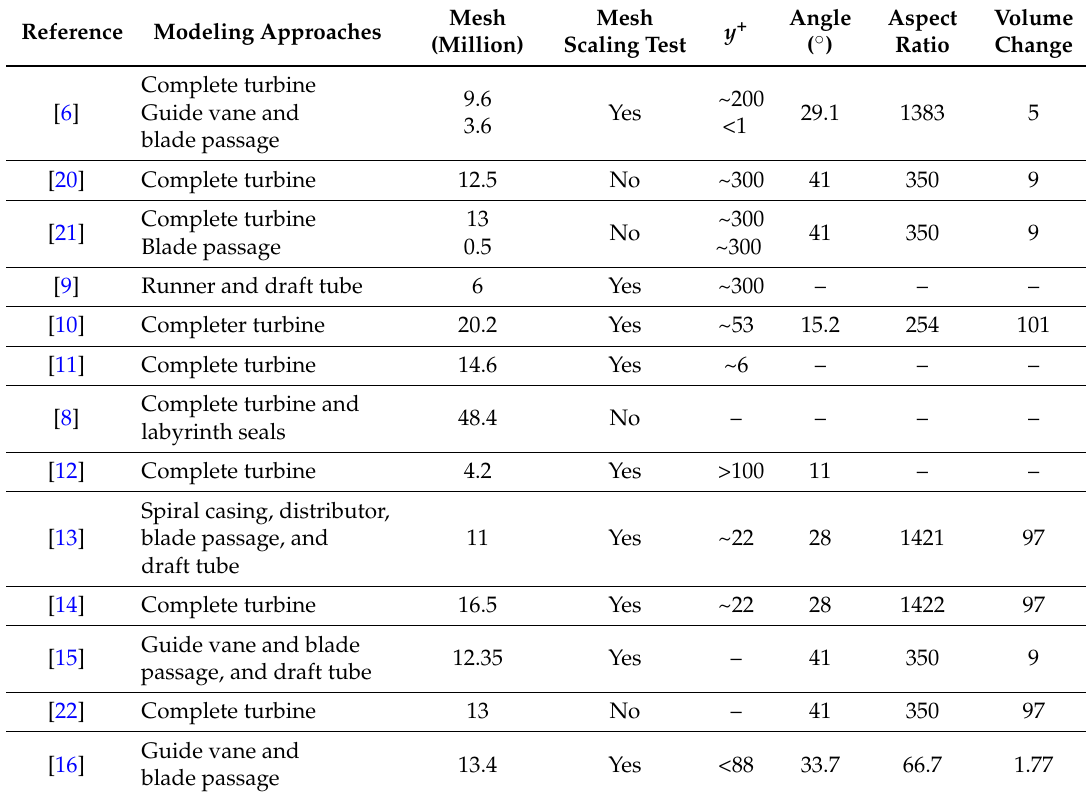
Table 3. Summary of the applied modeling approaches, meshing, and dimensionless node distance from the boundary ( y + ) and the mesh